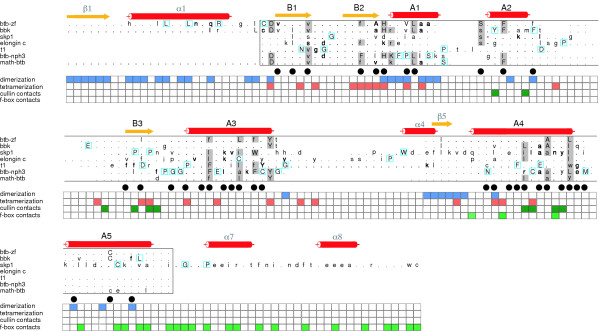
Sequence conservation in BTB domains. The most probable sequences (majority-rule consensus sequences) from each of seven different family-specific hidden Markov models (HMMs) were generated with HMMER hmmemit. Residue positions with a probability score (P(s)) of less than 0.6 are variable and are indicated by dots, residues with 0.6 < P(s) < 0.8 have intermediate levels of sequence conservation and are indicated by lower case letters, and residues with a P(s) > 0.8 are highly conserved and are indicated by capital letters. Gray shading indicates positions that are similar in at least four of the seven families shown, and selected 'signature sequences' that are particular to a specific family are boxed in blue. Gaps are indicated by blank spaces. Residue positions that are buried in the core of the BTB fold are indicated with black circles, and contact sites for four known protein-protein interaction surfaces are shown in the grid below the alignment. The secondary structure elements β1, α1, α4, β5, α7 and α8 occur only in some of the families, and are discussed in the text. Additional Data File 1 includes multiple sequence alignments for these families.